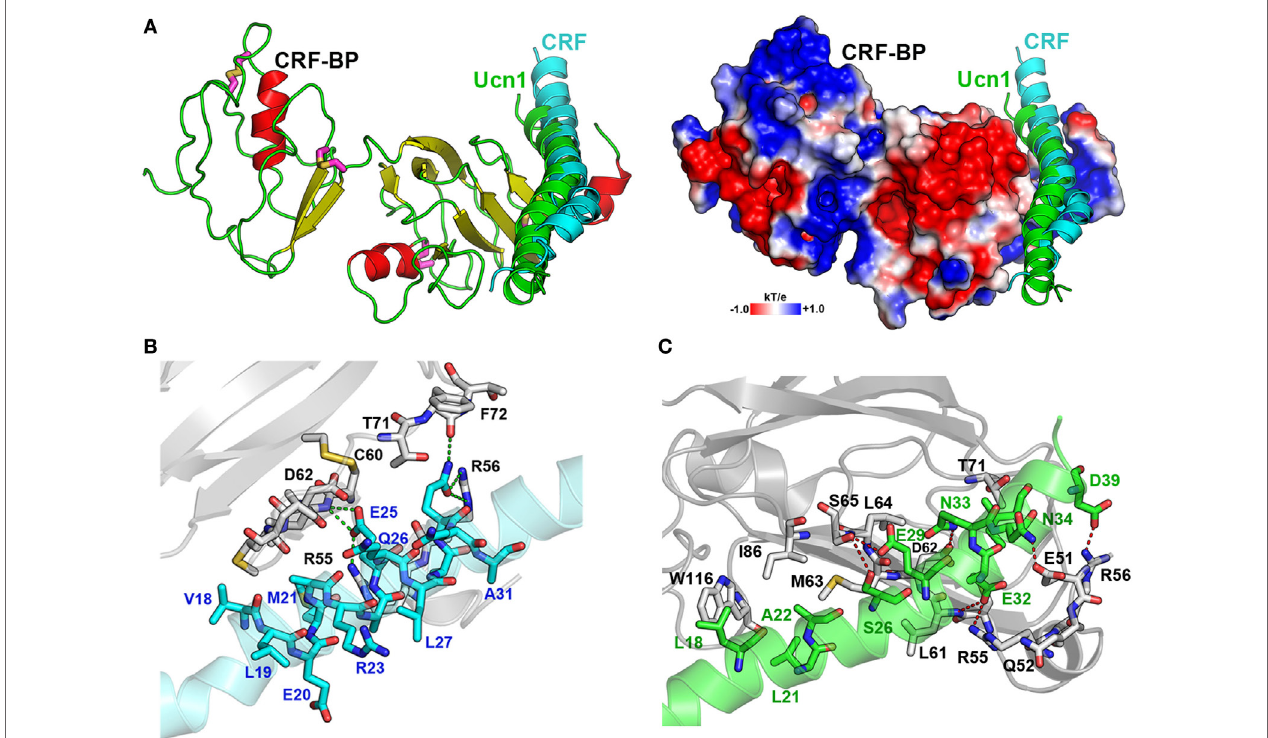
FigUre 2 | Protein-protein docking for CRF-BP with corticotropin-releasing factor (CRF) and UCNI. (a) Modeling of the interaction of CRF-BP with CRF and UCNI showing the secondary structure and the electrostatic potential surface plotted onto the solvent accessible surface of CRF-BP. (B,c) Magnifications of the interacting interfaces of CRF-BP with CRF (B) and CRF-BP with UCNI (c) . The interaction-important residues are shown with their carbon atoms in color, CRF-BP (white), CRF (cyan), and UCNI (green).